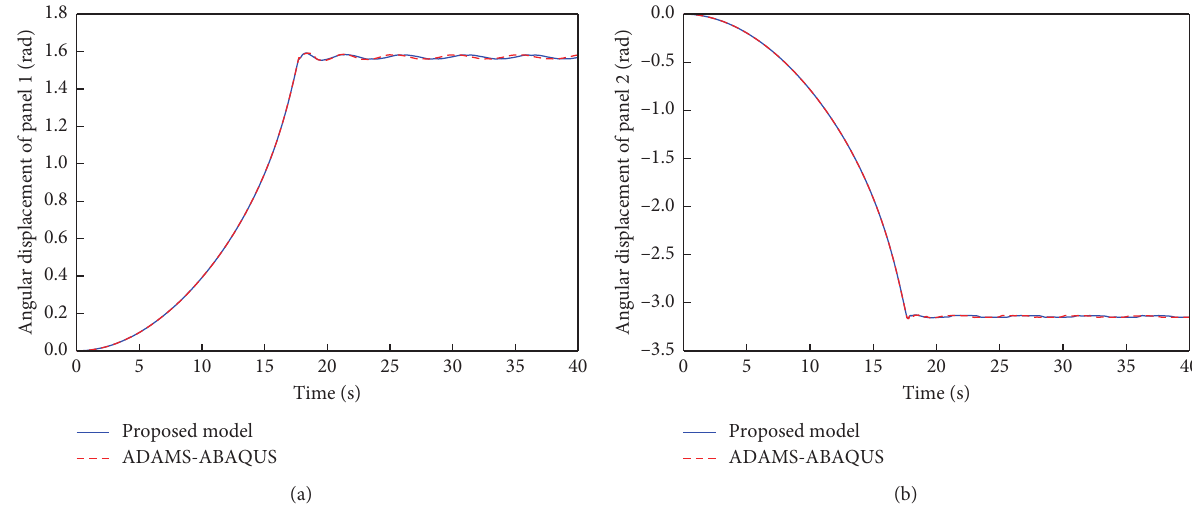
Figure 10: Comparison results of angular displacements of two solar panels between the proposed method and cosimulation of ADAMS- ABAQUS software.